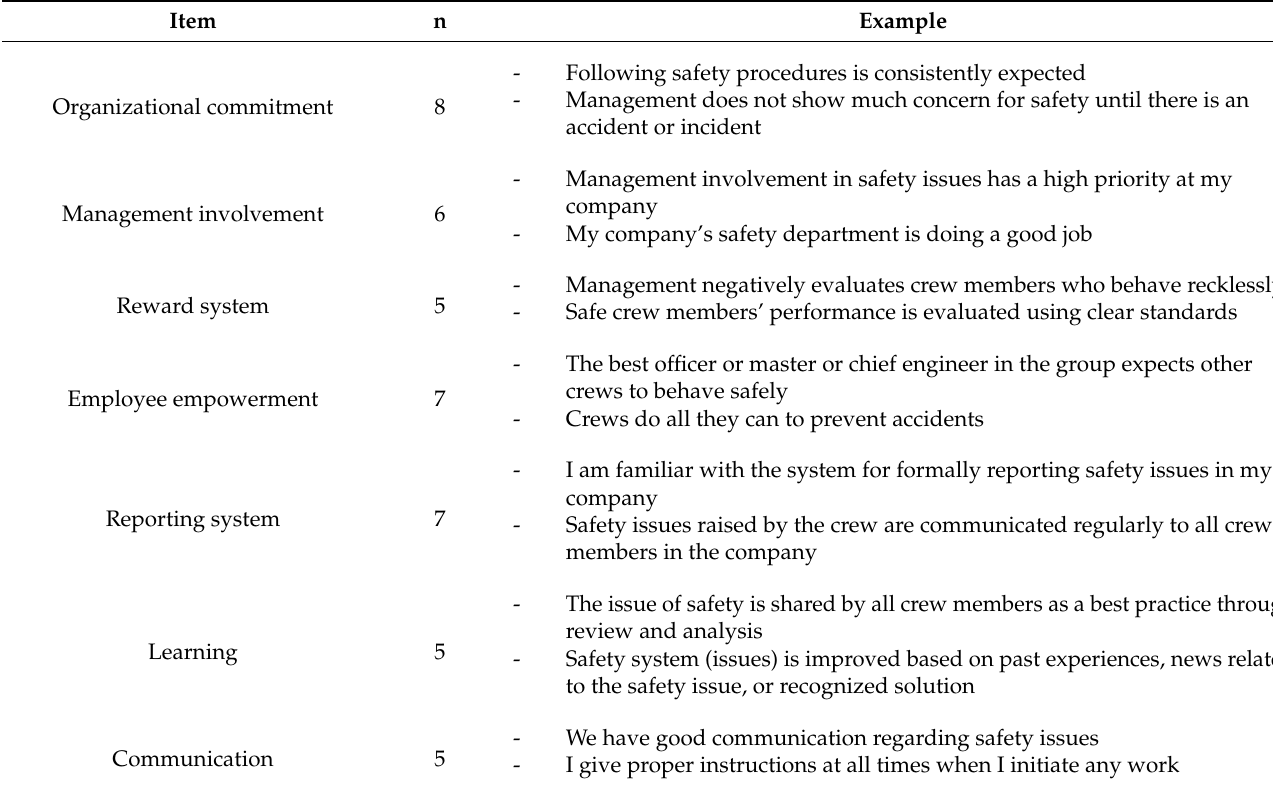
Table 5. Questionnaire item examples (Source: adopted from